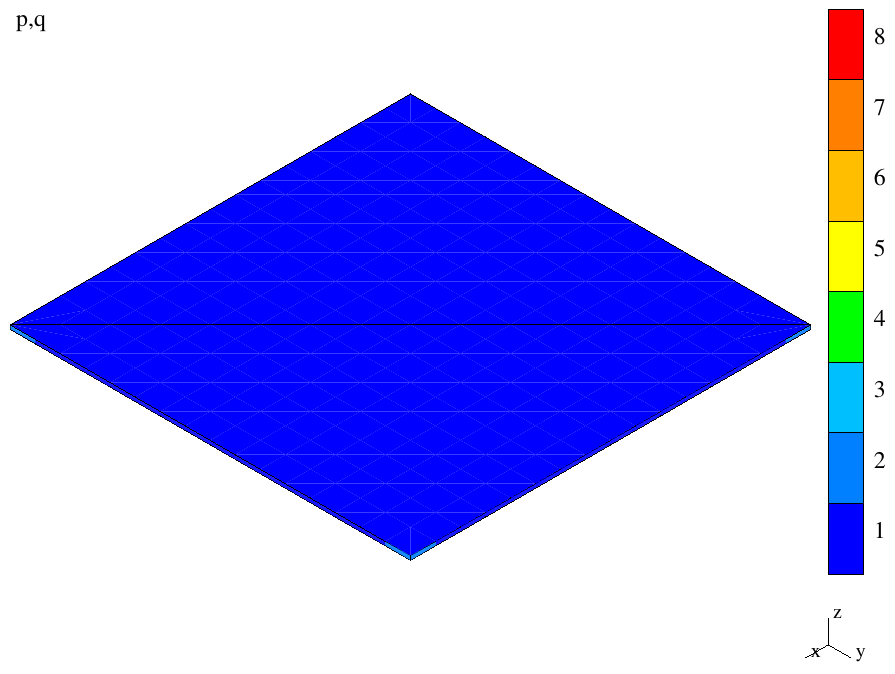
Figure 15. A bending-dominated plate—initial